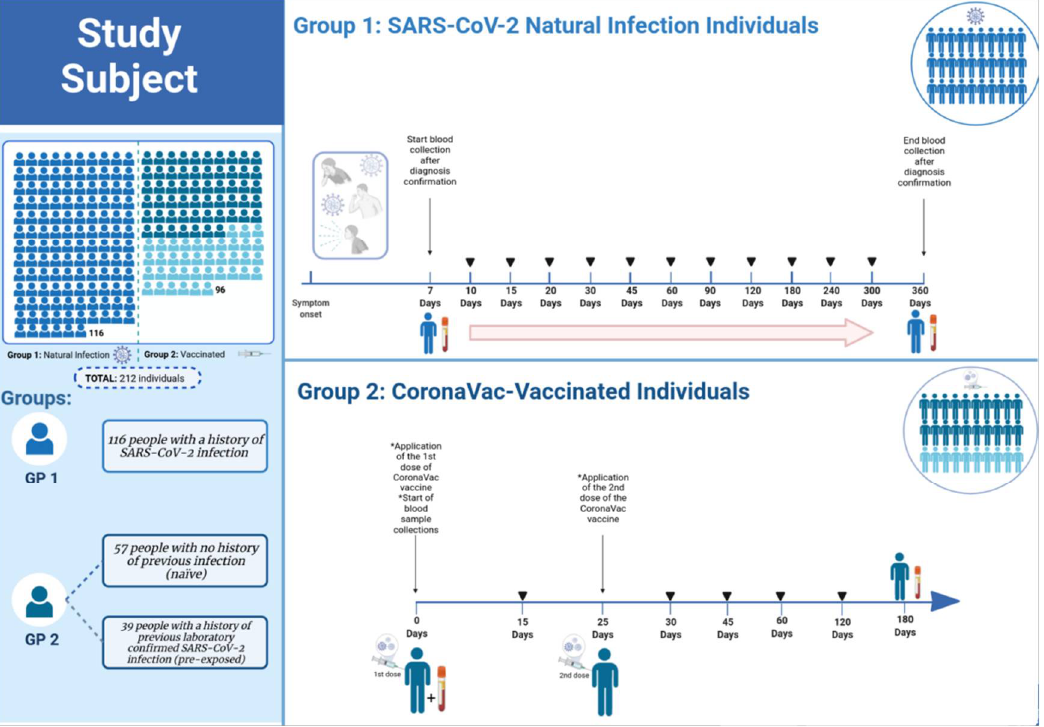
Figure 1. Experimental design of group 1 and group 2. In 116 individuals infected with SARS-CoV-2 belonging to Group 1, serial blood draws were performed alternately between seven days and 12-months post symptom onset. In group 2, 96 individuals vaccinated with CoronaVac were split into two subgroups: 39 with a history of previous laboratory-confirmed SARS-CoV-2 infection and 57 with no history of prior infection (naïve). Blood samples were collected immediately before the first dose, day 0, and serially on days 15, 30, 45, 60, 120, and 180-days post first immunization. All participants received the second dose of the CoronaVac vaccine 25 days after the first dose. GP—Group. Table 1. Participant characteristics.